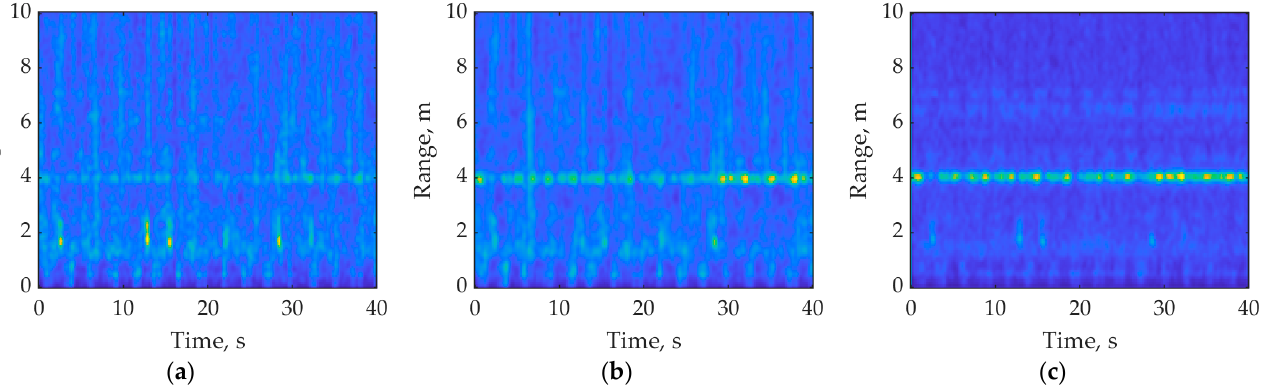
Figure 7. Two-dimensional matrices of signals after processing according to the interperiodic subtraction algorithm ( a ), local variance algorithm ( b ) and NDS algorithm ( c ). The warmer tones correspond to more intensive reflection.